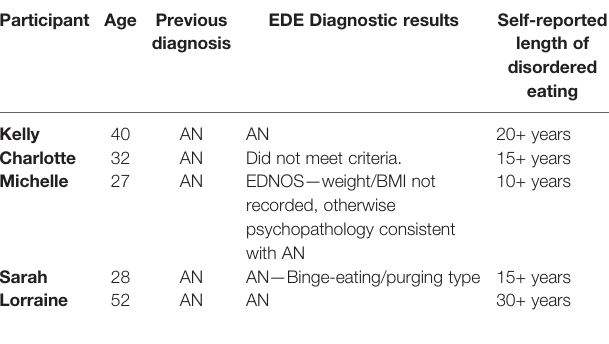
TABLE 1 | Participant